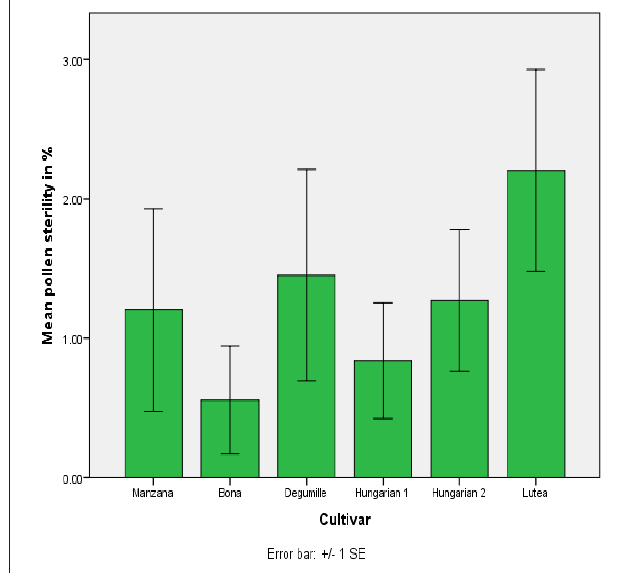
Fig. 3: Mean percentages of pollen sterility in six varieties of the parental generation